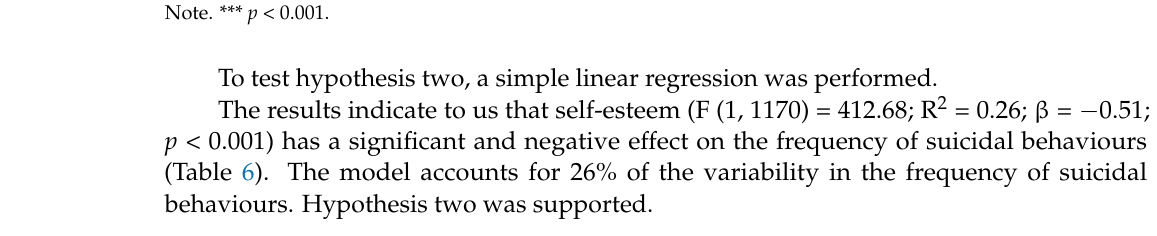
Table 6. Simple linear regression results